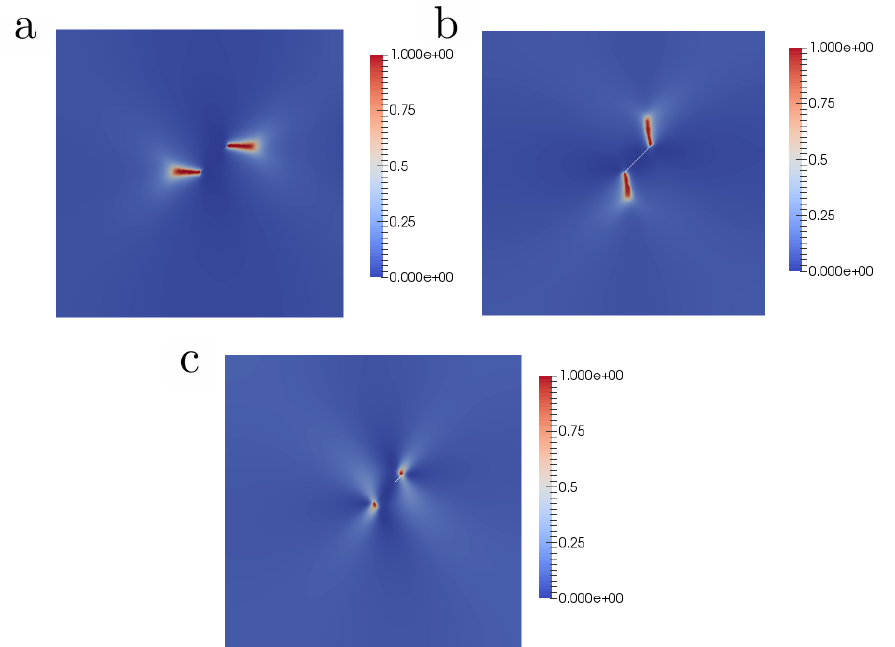
Figure 6. Different loading scenarios for a specimen with a single flaw: predicted damage patterns. ( a ) Uniaxial tensile case. ( b ) Vertical compression and horizontal traction with ¯ u y / ¯ u x = − 1. ( c ) Vertical compression and horizontal traction with ¯ u y / ¯ u x = −